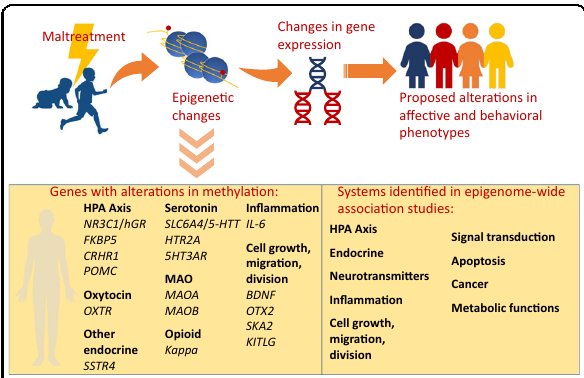
Fig. 2 Conceptual diagram representing the epigenetic pathway from maltreatment to health and mental health outcomes. Note: This review presents data focused on the relationship between maltreatment and alterations in methylation, whereas the proposed alterations in affective and behavioral phenotypes are explored further